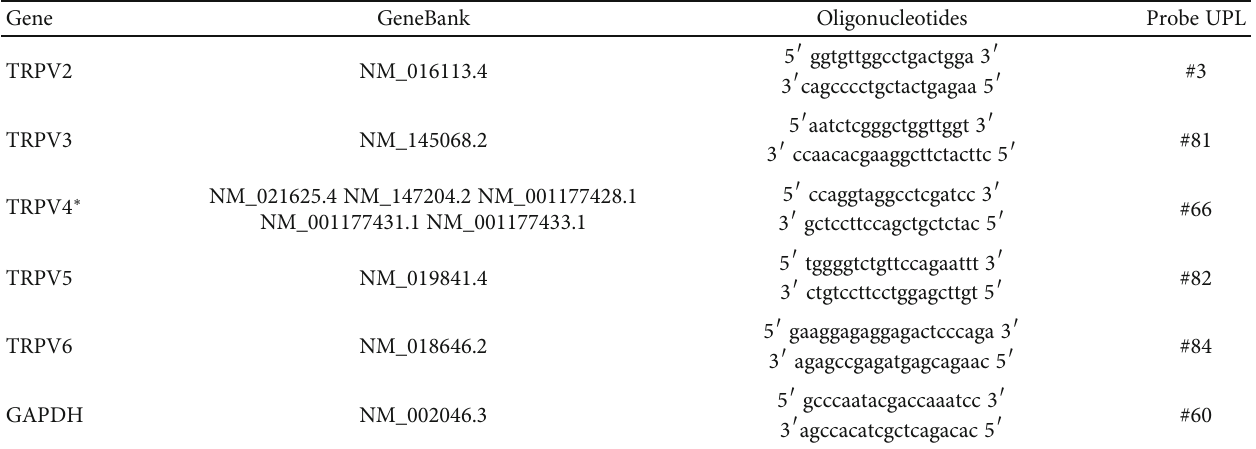
Table 1: Primers designs from Universal ProbeLibrary.